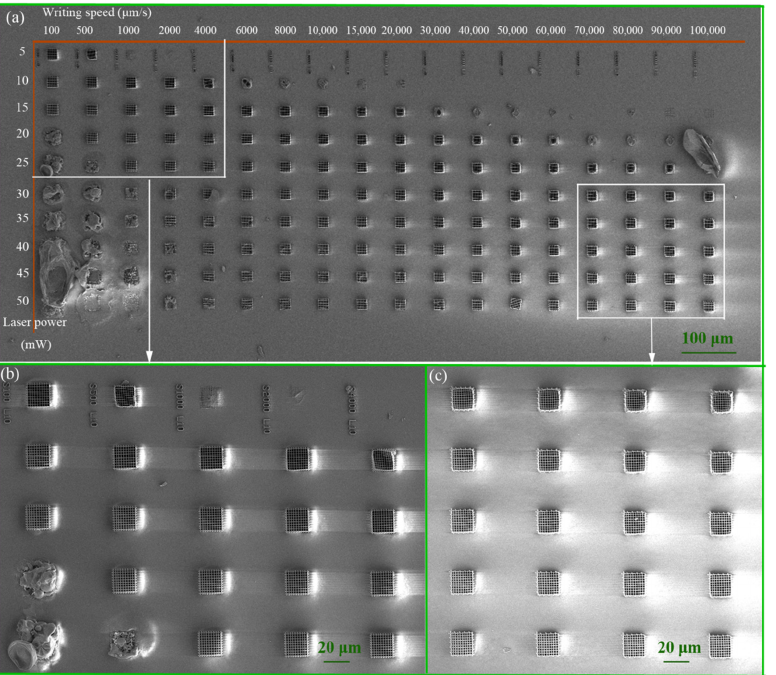
Figure 7. ( a ) SEM images of structures with initiator BM-PPPM-C6 (10 μ mol/g) in TMPTA. ( b ) Enlarged view of low writing speed area. ( c ) Enlarged view of high writing speed area.